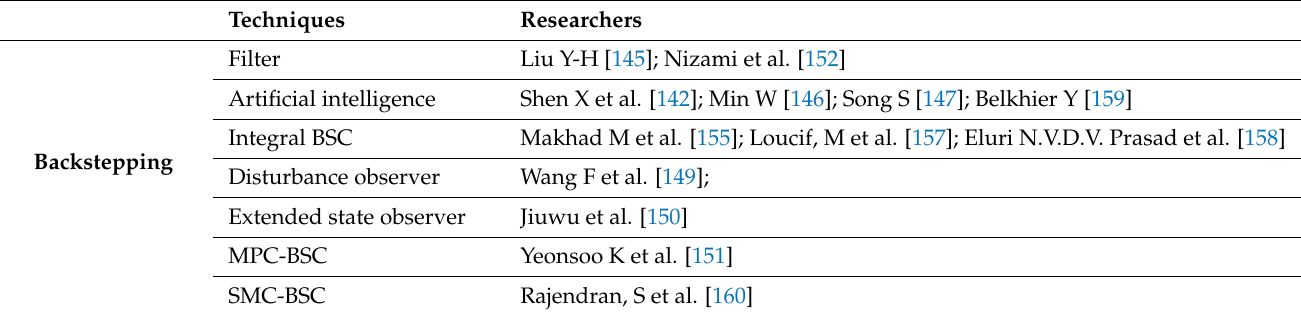
Table 7. Various techniques used for BSC control. Techniques